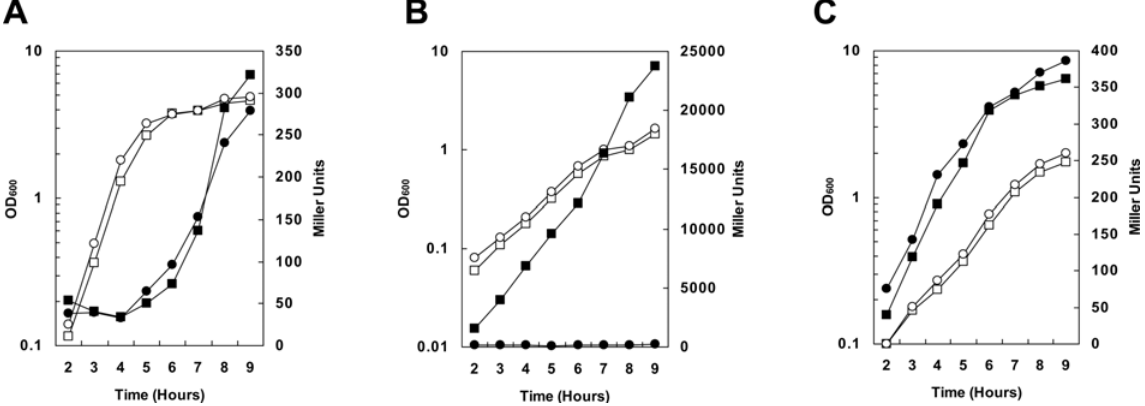
Figure 2. Cell growth and virulence gene expression in B.anthracis 34F2 and 34F2 D BAS2714-12 under various growth conditions. For b -galactoside assays, cells carrying a pagA-lacZ or atxA-lacZ fusion on the replicative vector pTCV- lac were grown in medium supplemented with Kanamycin. b -galactosidase assays were carried out on samples taken at hourly intervals as indicated. (A) pagA-lacZ reporter strains grown in LB broth in air at 37 u C. (B) pagA-lacZ reporter strains grown in R Media with 0.8% NaHCO 3 under 5% CO 2 at 37 u C. (C) atxA-lacZ reporter strains grown in R Media with 0.8% NaHCO 3 under 5% CO 2 at 37 u C. Symbols in all panels: - % - 34F2 cell growth; - # - 34F2 D BAS2714-12 cell growth; - & - 34F2 LacZ expression; - $ - 34F2 D BAS2714-12 LacZ